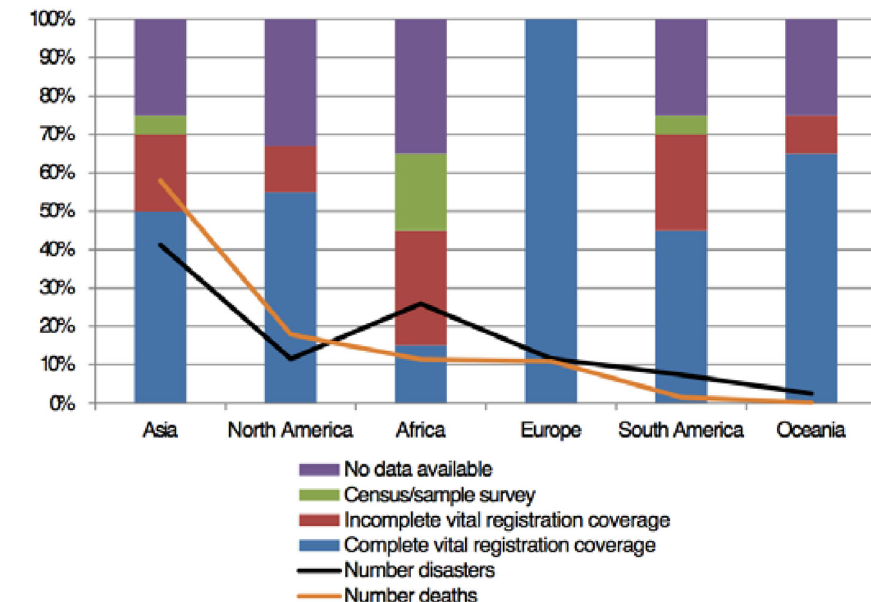
Fig. 2 Proportion of countries by region where vital registration data are available and proportional disaster impact. Source Vital registration data: United Nations Statistics